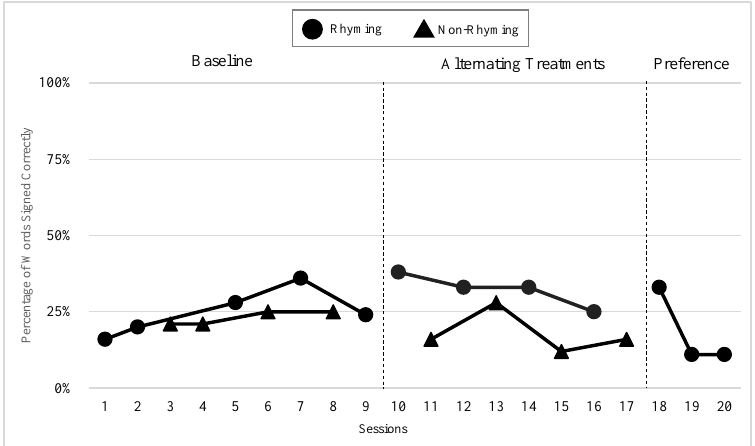
Figure 7. Daya’s Percentage of Words Signed Correctly in Recitation.